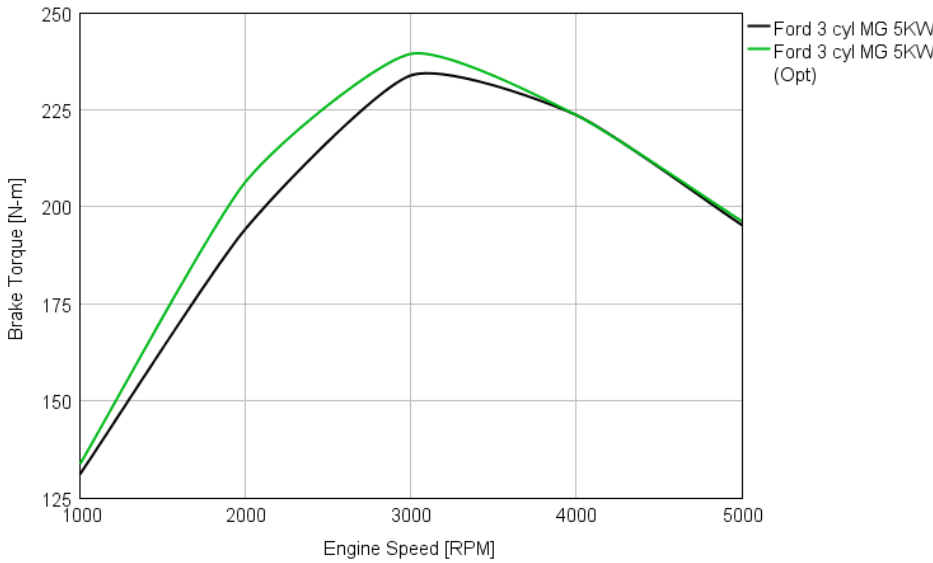
Figure 28. Brake torque graphs for the initial (black) and optimized (green) EAT 5 kW models.